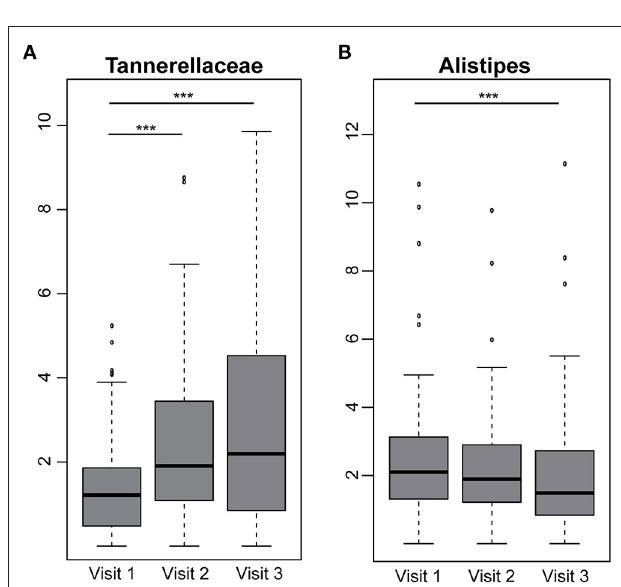
FIGURE 5 | Differences between visits in individuals receiving fiber-enriched foods. Boxplots are showing the relative abundance values of the family (A) Tannerellaceae and the genus (B) Alistipes. Significance is shown between groups (Benjamin Hochberg adj. p < 0.05), *** p <